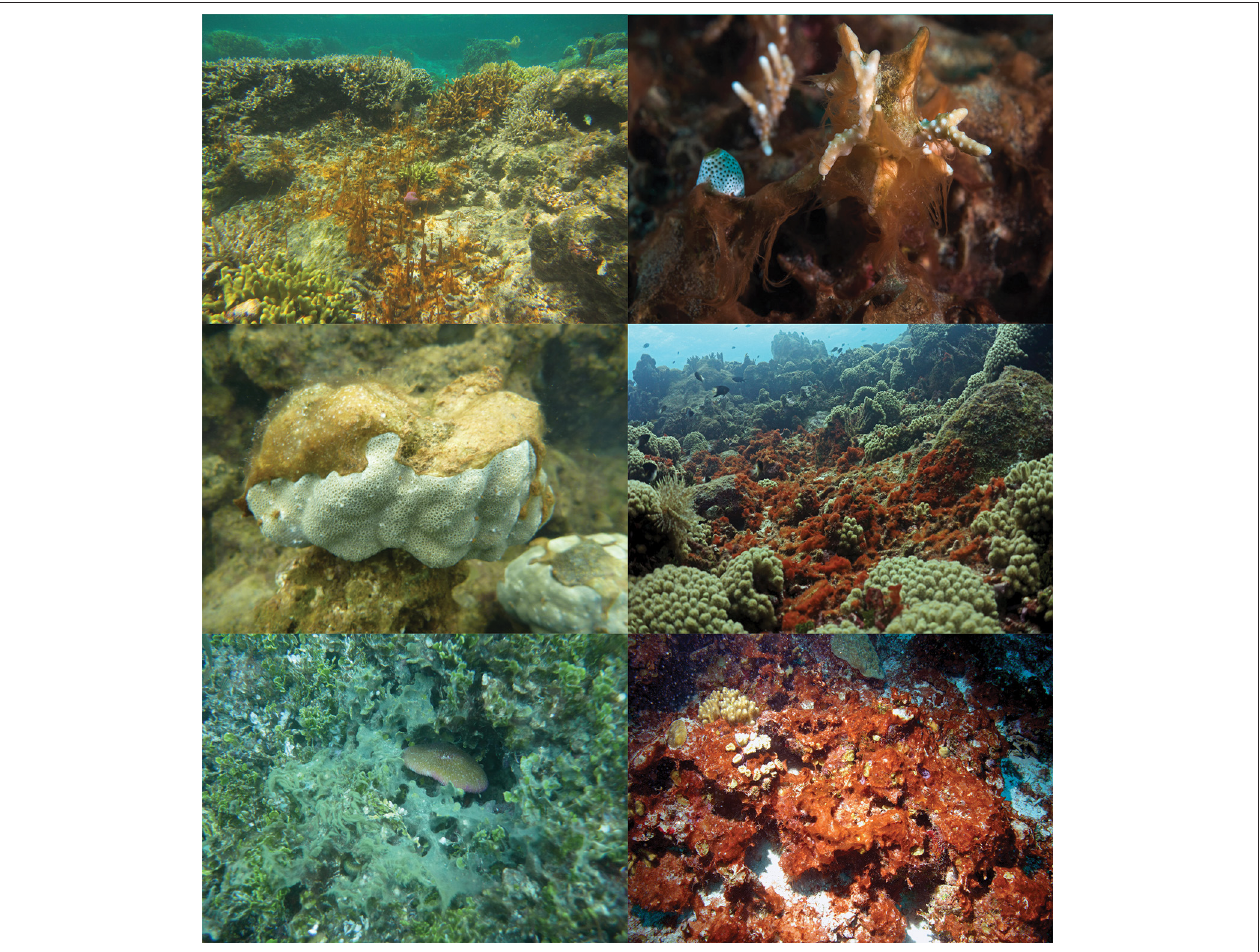
FIGURE 1 | Photographs of benthic cyanobacterial mats on coral reefs. From top-left clockwise: cyanobacterial mat at Coral Coast, Fiji (credits: Victor Bonito); cyanobacterial mat overgrowing coral at Menjangan Island, Bali (credits: Tom Vierus); Oscillatoria -dominated mat at Curaçao (credits: Benjamin Mueller); Oscillatoria -dominated mat at Curaçao (credits: Maggy Nugues); cyanobacterial mat overgrowing Halimeda algae at Ahus Island, Papua New Guinea (credits: Amanda Ford); cyanobacteria mat overgrowing coral at Marovo Lagoon, Solomon Islands (credits: Simon